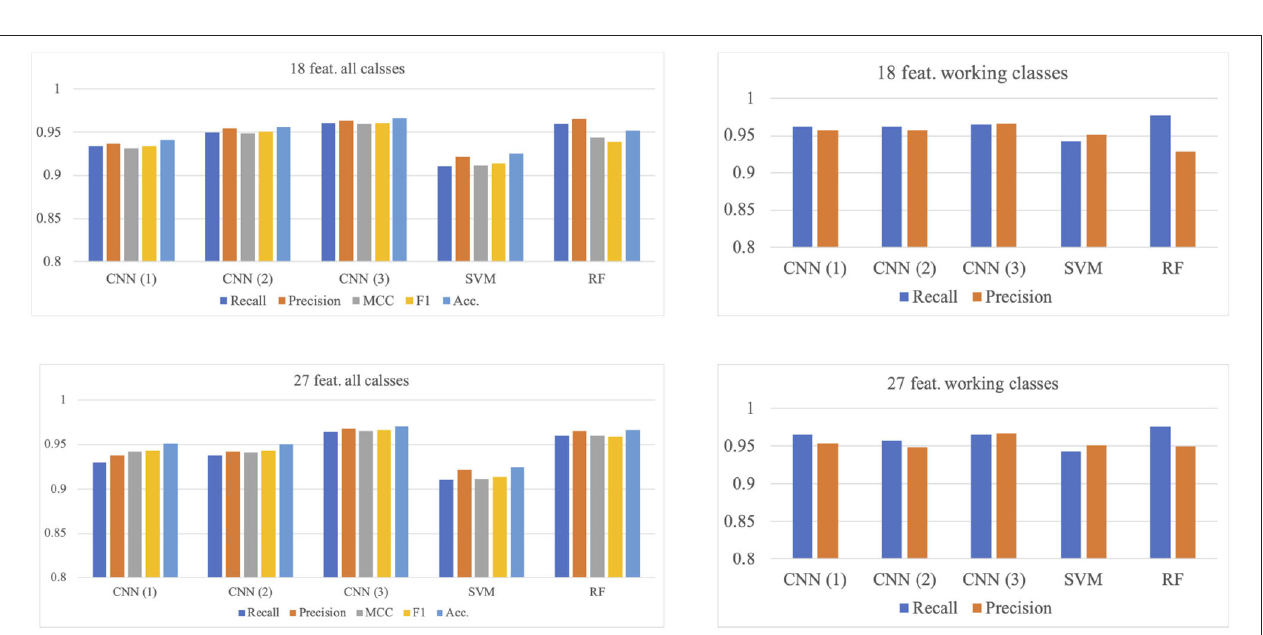
FIGURE 3 | The averaged 8-s matrices for the seven classes. The matrices on the left column corresponds to W_N , St_N , Si_N , L_N , respectively, whereas those on the right column corresponds to Re , Ty , and Wr , respectively. The horizontal axis corresponds the maximum eigenvector of the correlation matrix, the means, standard deviation, and the of the nine channels.